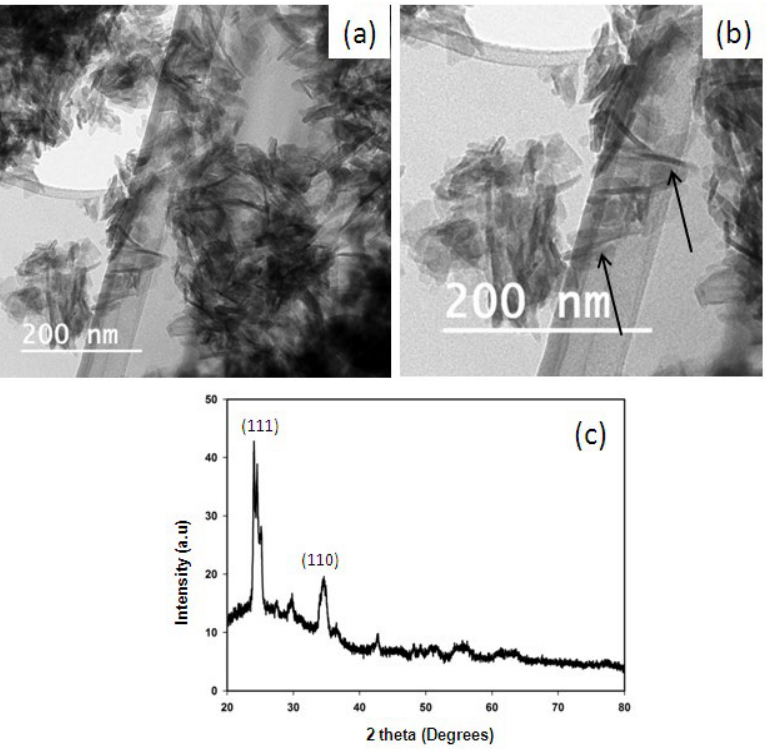
Figure 2. Characterization of HANPs prepared using the microwave method: HRTEM images showing the needle-shaped nanoparticles of 30 nm width and 90 nm length ( a , b ) and arrow indicate the needle shapted nanoparticles; XRD analysis of HANPs showing the crystalline nature of the particle with planes at (111) and (110) ( c